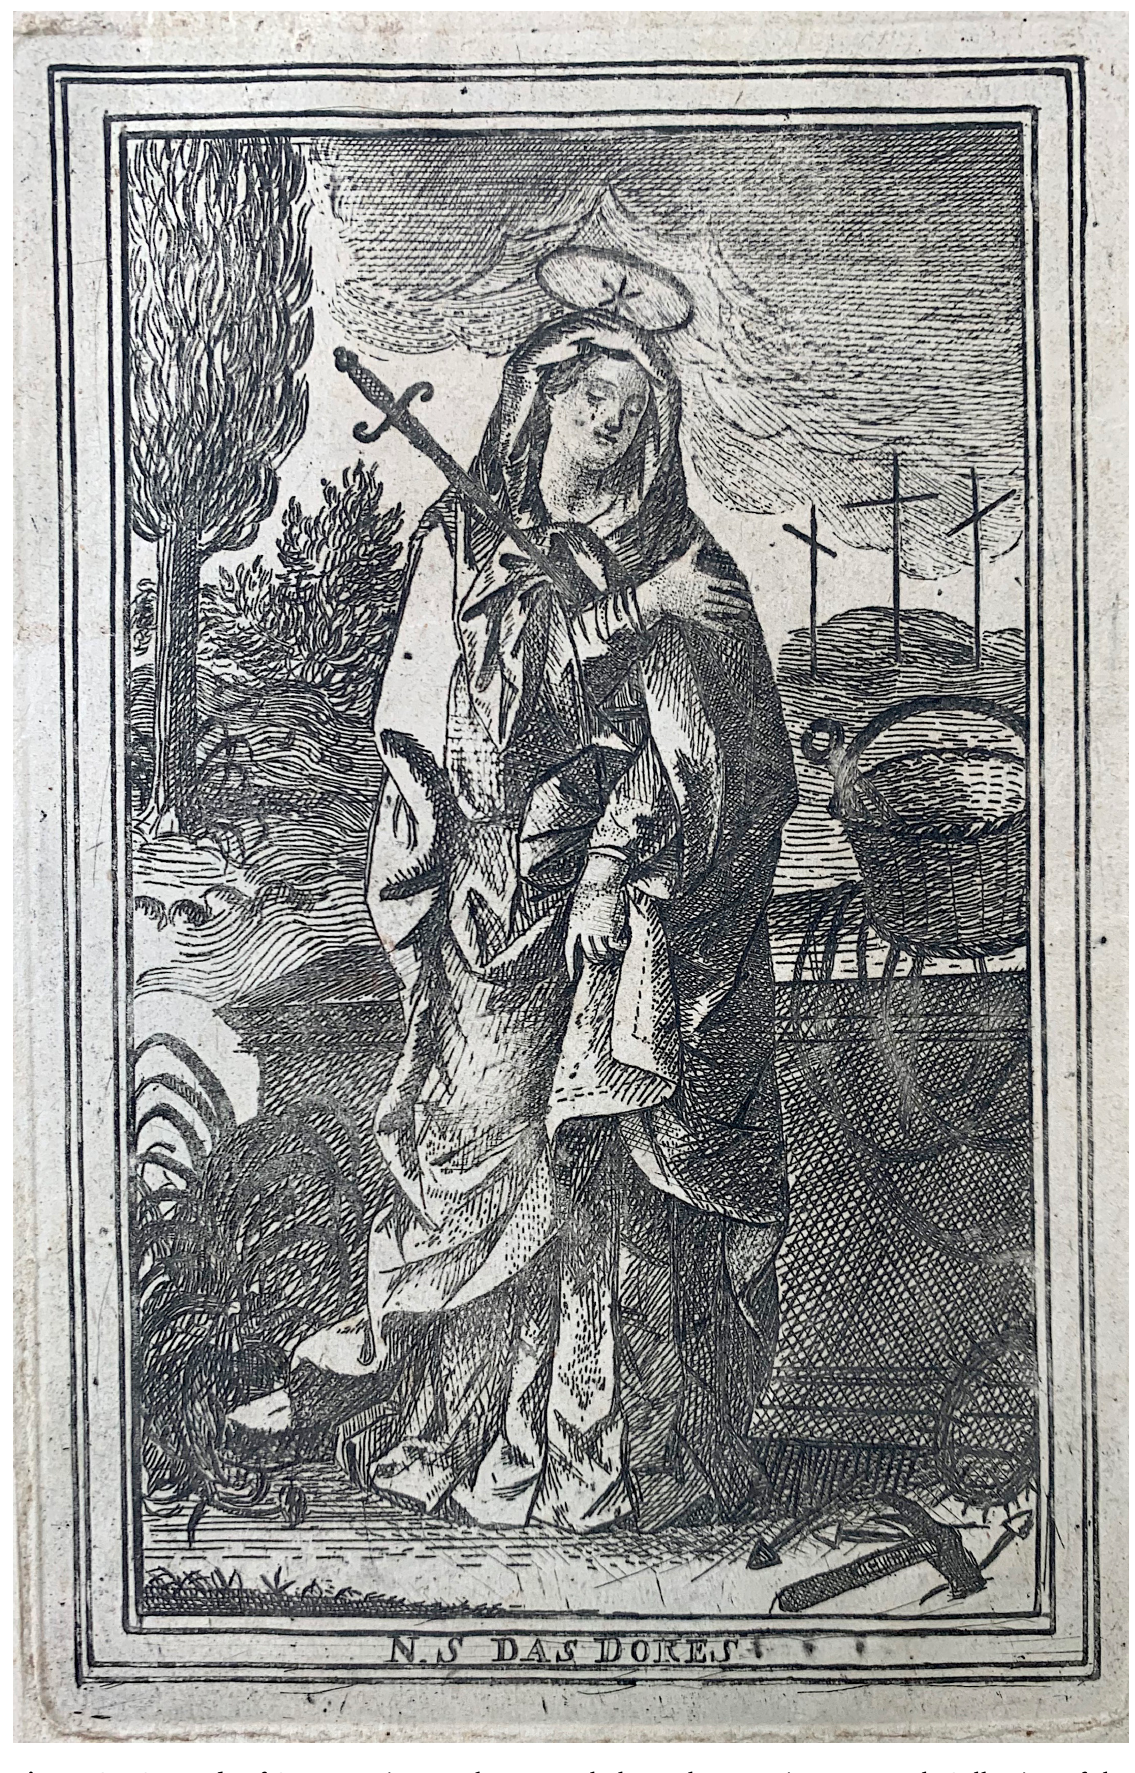
Figure 2 Our Lady of Sorrows , nineteenth century holy card, engraving, Portugal. Collection of the